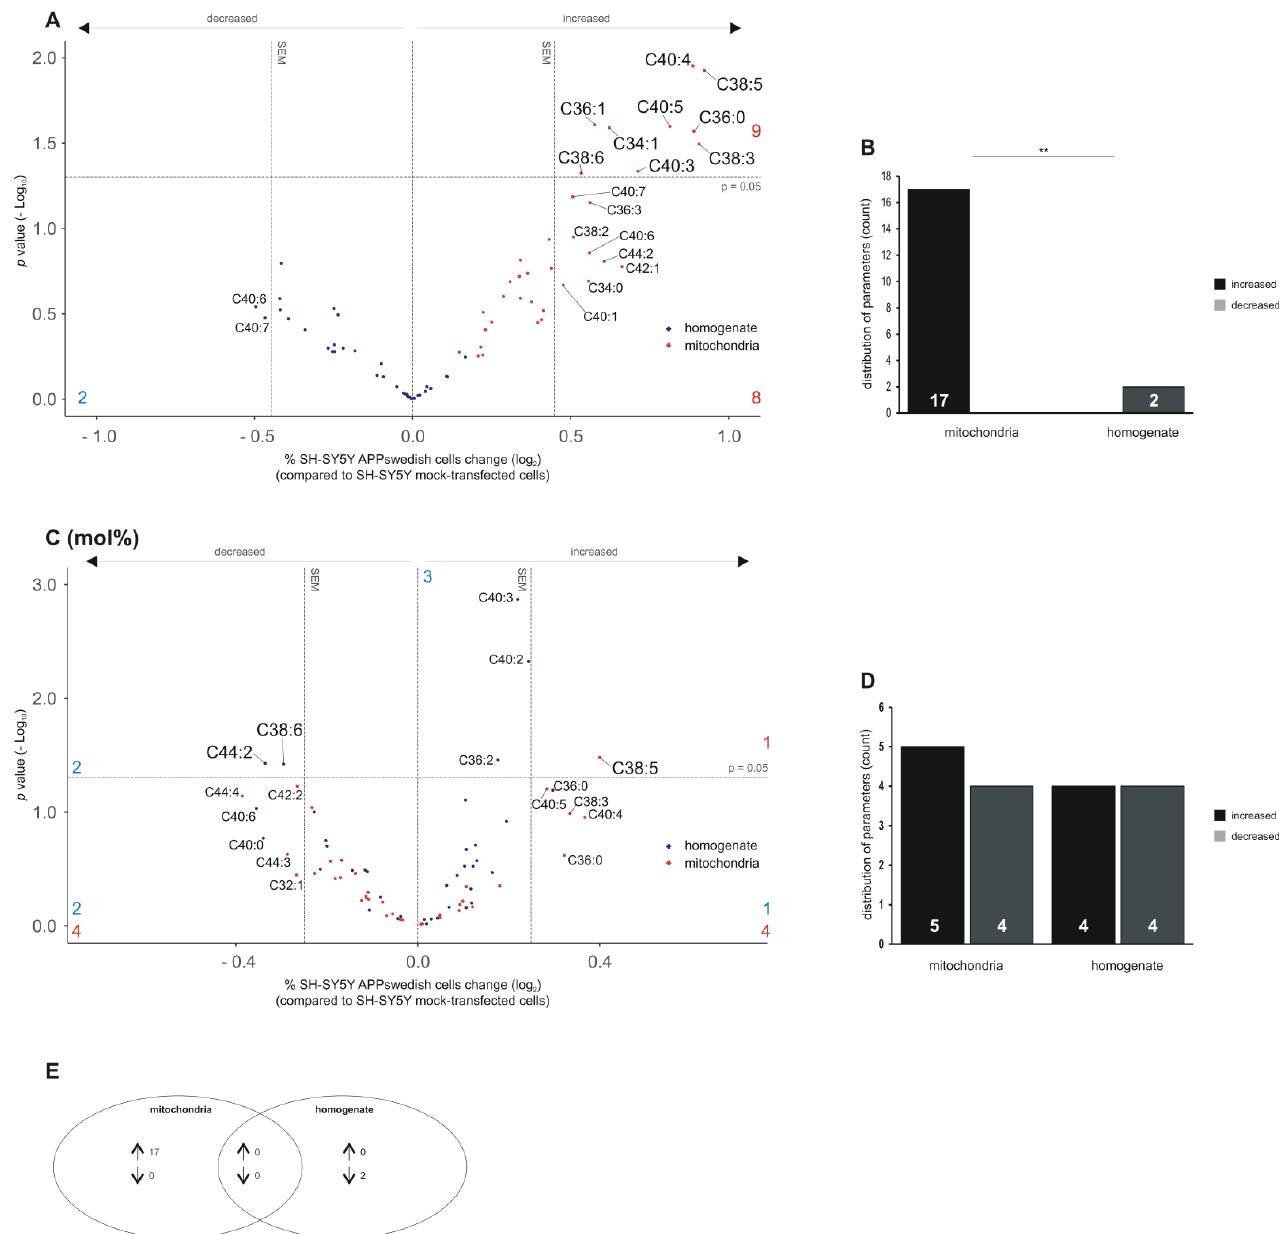
Figure 7. Changed phosphatidylethanolamine plasmalogens (PEae) levels in homogenates and mitochondria of SH-SY5Y APPswedish cells in comparison to mock-transfected SH-SY5Y cells, respectively. ( A , B ) The fold changes of single PEae species in homogenates and mitochondria are shown as volcano plots and the corresponding distribution analysis is shown in a bar chart on the right. ( C , D ) The effects of single PEae species independent of PEae lipid class effect are presented as appropriate volcano plot and bar chart. Vertical dashed lines next to 0.0 represent the average SEM and the horizontal dashed line marks p = 0.05 in volcano plots. Statistical significance was calculated using Fisher’s exact test with ** p ≤ 0.01. ( E ) Venn diagram showing the number of exclusively changed as well as overlapping PEae species in mitochondria and homogenates in SH-SY5Y APPswedish cells compared to mock-transfected cells. Arrows indicate decreasing ( ↓ ) or increasing ( ↑ ) effects.